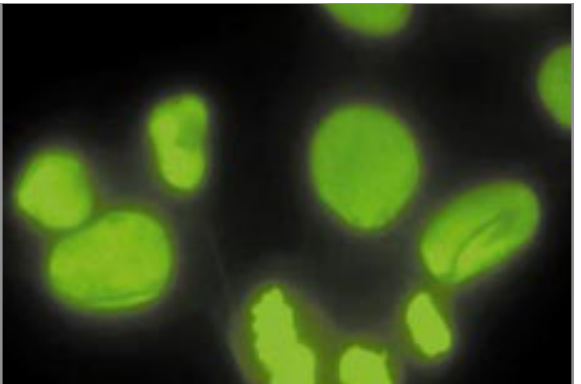
Figura 3 – Nuclear